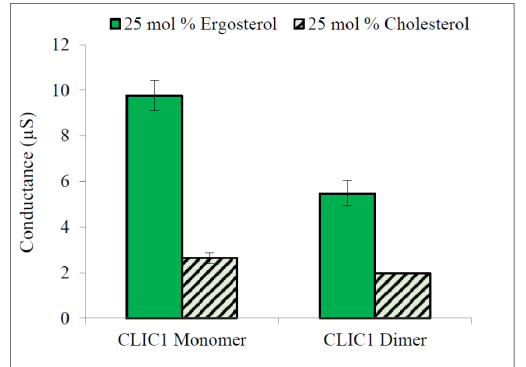
Figure 6. Conductance of CLIC1 in tBLMs containing 25 mol % ergosterol. 20 µg of CLIC1 monomer (pre-incubated with 0.5 mM TCEP) and dimer (pre-incubated with 2 mM H 2 O 2 ) in 100 µL of HEPES/KCl buffer (pH 6.5) were incorporated into membranes containing zwitterionic lipids and 25 mol % ergosterol. The error bars represent the standard error of three independent experimental repeats ( n = 3).